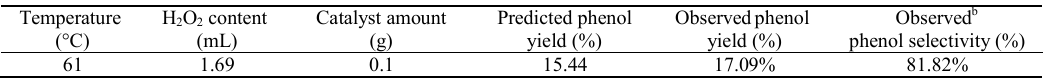
Table 4. Observed and predicted results of the phenol yield at the optimum points predicted by the RSM